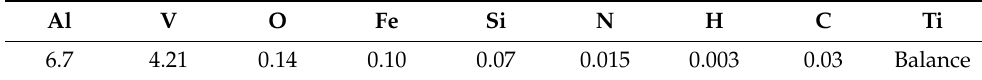
Table 1. Composition (wt %) of TC4.